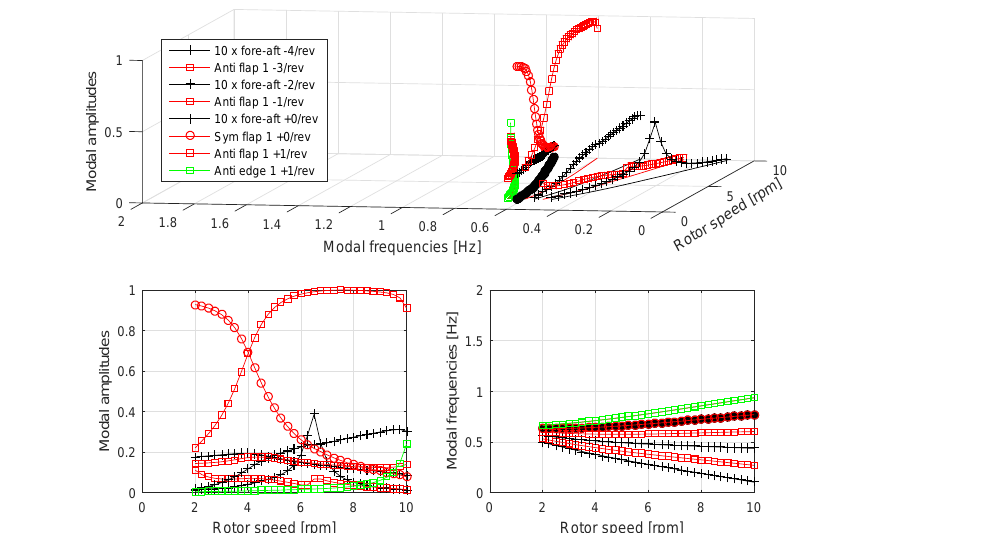
Figure 19. Harmonic modal components for the two-bladed turbine mode dominated by antisymmetric deflection of the rotor in the first flapwise DOF across the rotor speed range. Plot layout as in Fig.